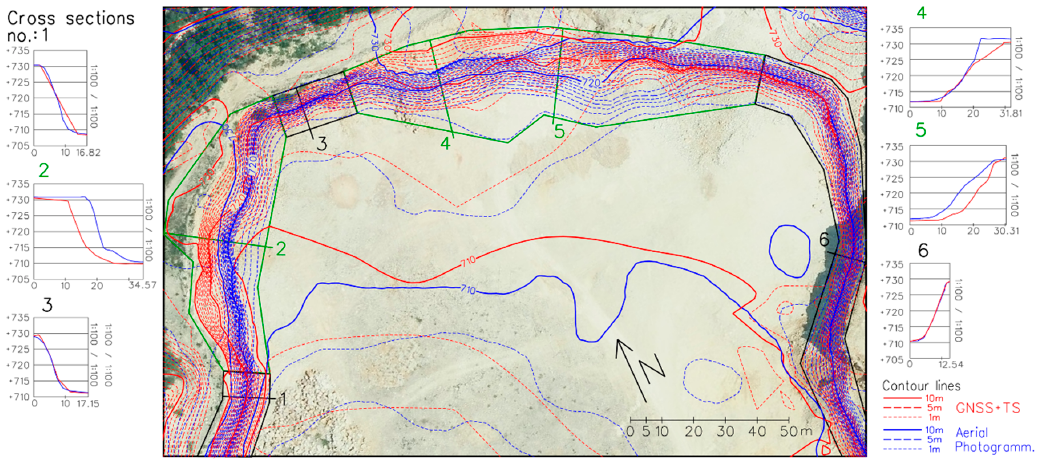
Figure 8. Graphical visualization of the contours of the rock wall of the pit bottom of the open-pit mine from the data of aerial photogrammetry and tachymetric measurement of the total station.